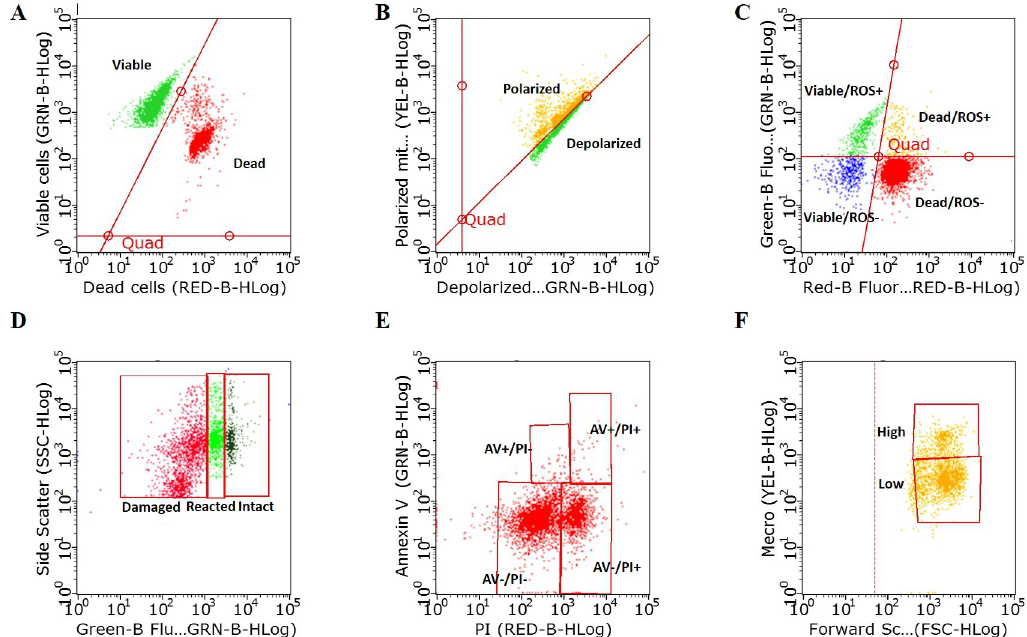
Fig 2. Evaluation of spermatozoa using the Guava EasyCyte microcapillary flow cytometer. Scatter plots of (A) viable and dead spermatozoa, (B) polarized and depolarized spermatozoa, (C) viable spermatozoa with or without ROS and dead spermatozoa with or without ROS, (D) spermatozoa with damaged, reacted, and intact acrosomal membranes, (E) annexin V (AV) positive (+) with negative (-) and positive (+) propidium iodide (PI), and AV- with PI- and PI+ spermatozoa, and (F) high- and low-intensity merocyanine 540 staining of